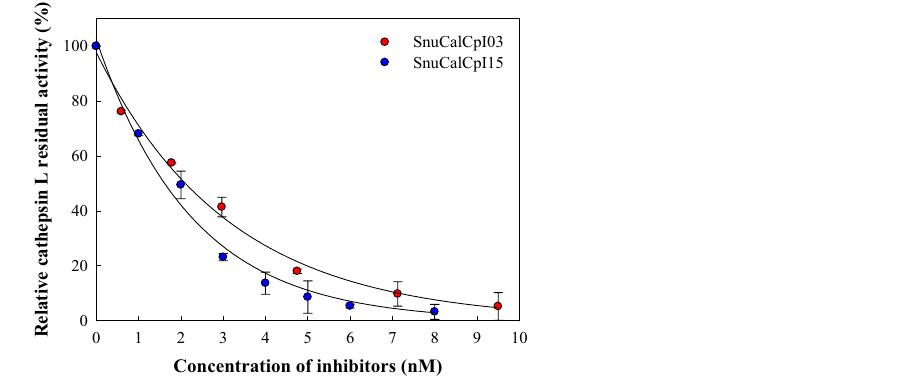
Figure 2. Inhibitory activity of SnuCalCpIs against human cathepsin